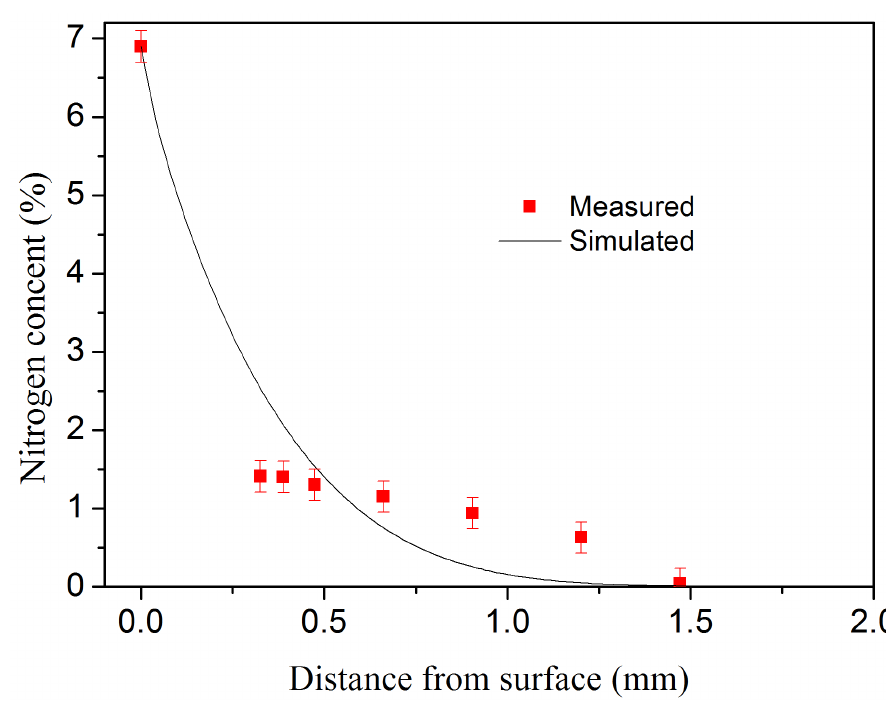
Fig. 4 Nitrogen concentration simulated results in SCr420H